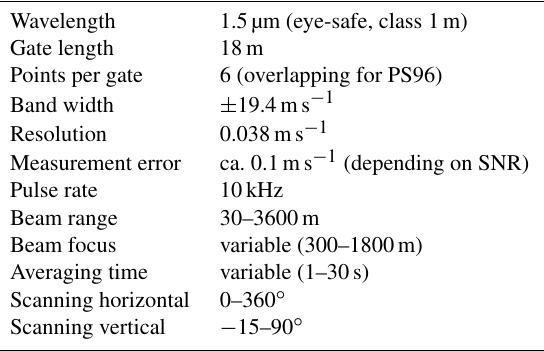
Figure 1. Cruise track of Polarstern during PS85 (a) and PS96 (b) with different colours for every week (symbol mark every day 00:00UTC). Beside land (dark grey) and water (dark blue), sea ice concentration ( > 15%) during the measuring period is shown to be present every day (light grey) and present at least 1 day (light blue). Sea ice concentration is taken from AMSR2 (Spreen et al., 2008). Table 1. Characteristics of the lidar